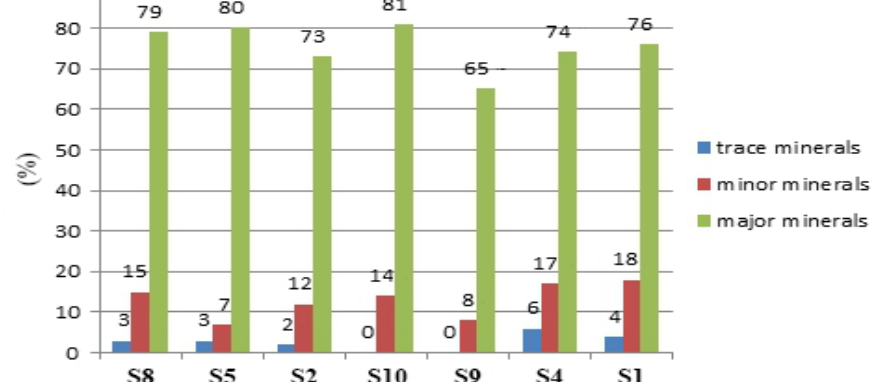
Fig. 4: percent of trace, minor, and major minerals in the sediment samples of Taleghan Basin